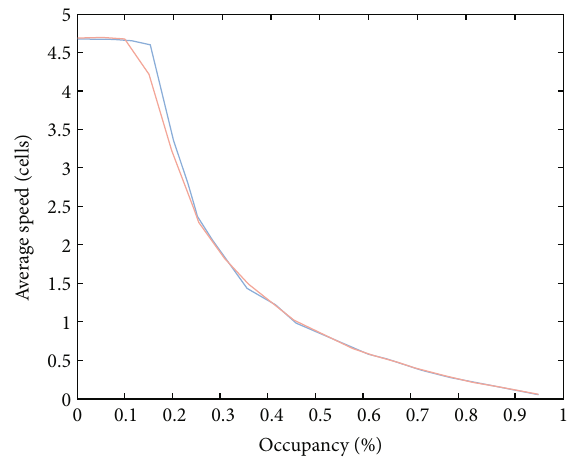
Figure 4: Average speed-space occupancy fi